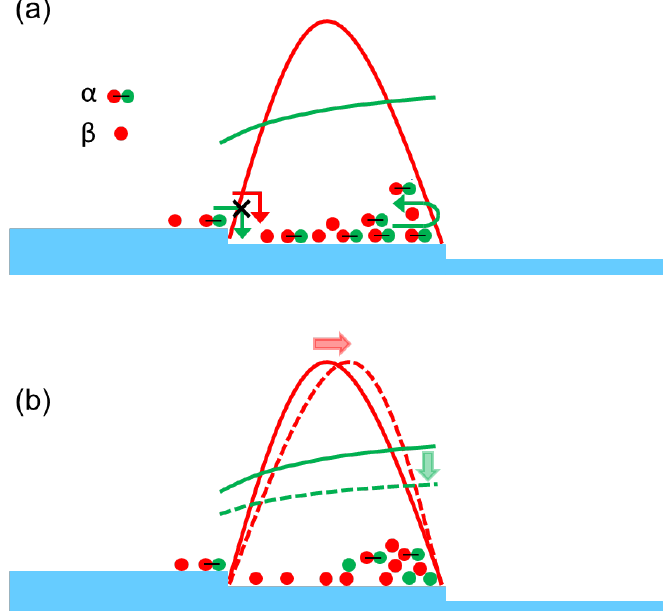
Figure 5. Schematic illustration of the two-particle model proposed by Pimpinelli et al. [26 – 31]. In the figure, the precursor molecules α are depicted as a combination of red and green spheres, while the adatoms β are depicted as red spheres, which are generated through the cracking of the precursor molecules α on the growing crystal surface. ( a ) shows the distributions of the precursor molecules α and adatoms β without taking into account the cracking of the precursor molecules, whereas ( b ) shows the distributions within it.